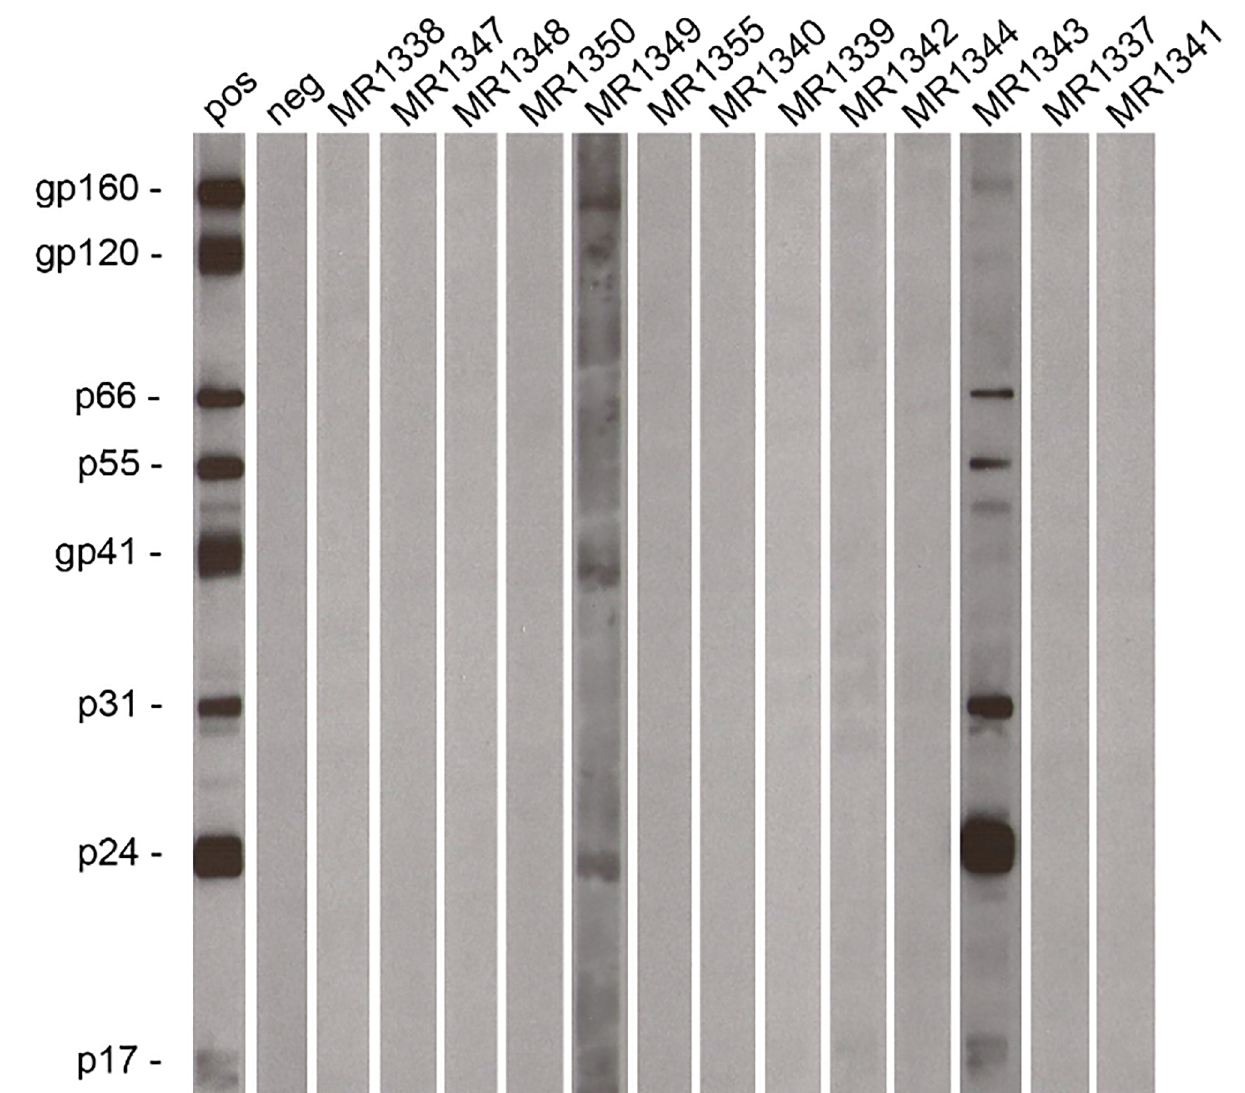
Fig 4. Evidence of SIVcpz infection on the southern bank of the MalagarasiRiver. Chimpanzee fecal samples were tested for HIV/SIV specific antibodies using an enhanced chemiluminescent Western blot approach and HIV-1 antigencontainingstrips. Samplesfrom individuals (Ch-2 and Ch-5; Table 1) reacted with envelope, integraseand/or core proteins, indicating SIVcpz infection. Molecularweights of HIV-1 specific proteins are indicated. The bandingpattern of plasma from an HIV-1 infected subject (pos at a 1:1,000,000dilution) and an uninfectedhumancontrol (neg) are